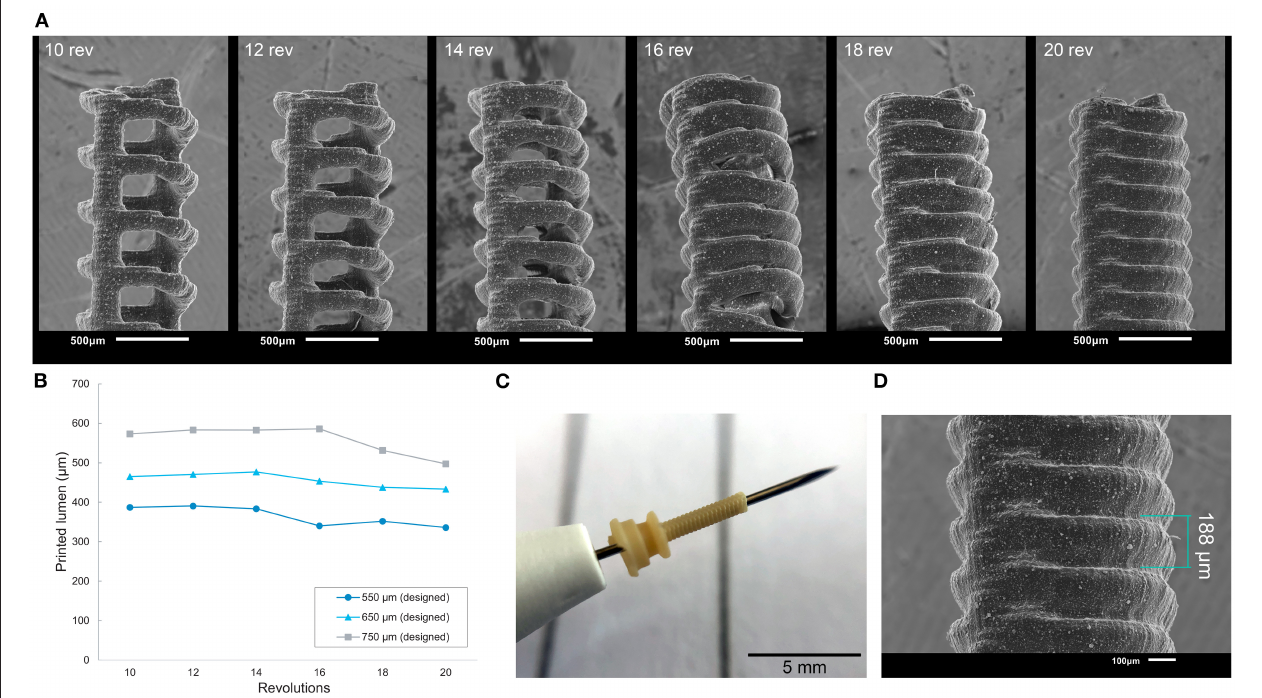
FIGURE 6 | Results of the new cannula design. (A) SEM images of the tips of the cannulas showing the effects of different numbers of revolutions of the helix. (B) Influence of the number of revolutions on the size of the internal channel of the cannulas. (C) close up of a 3D printed helix cannula placed on the tip of a 27G inserter knife. (D) SEM image and measurements of the helix cannula with 20 revolutions.